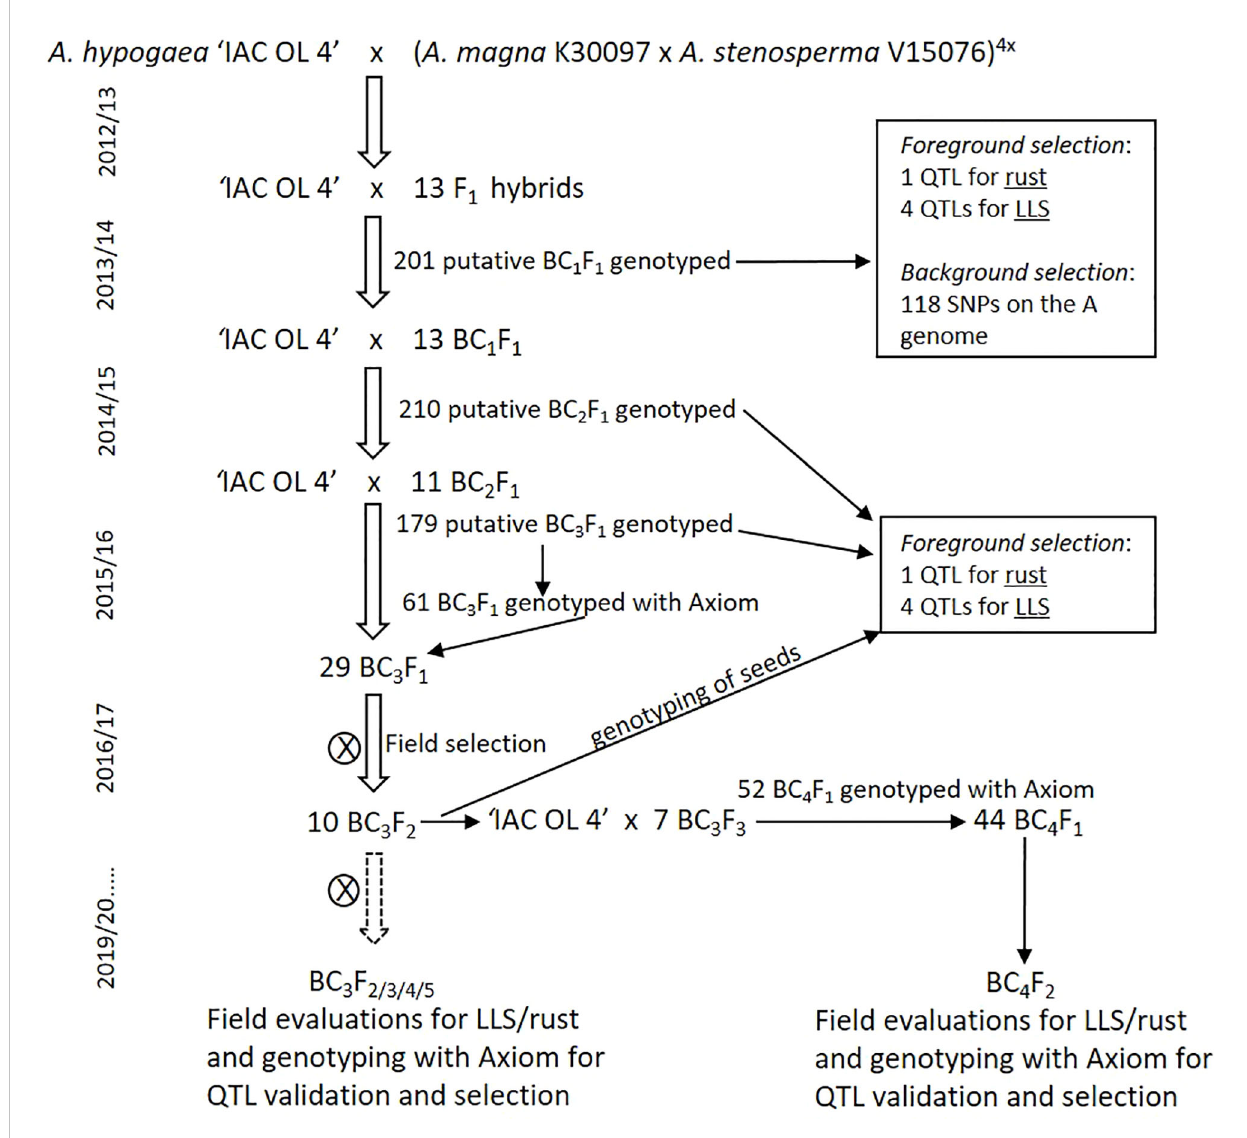
FIGURE 1 Marker-assisted backcrossing schedule for introgressing chromosome segments from A. magna K 30097 and A. stenosperma V 15076 into the peanut cultivar IAC OL